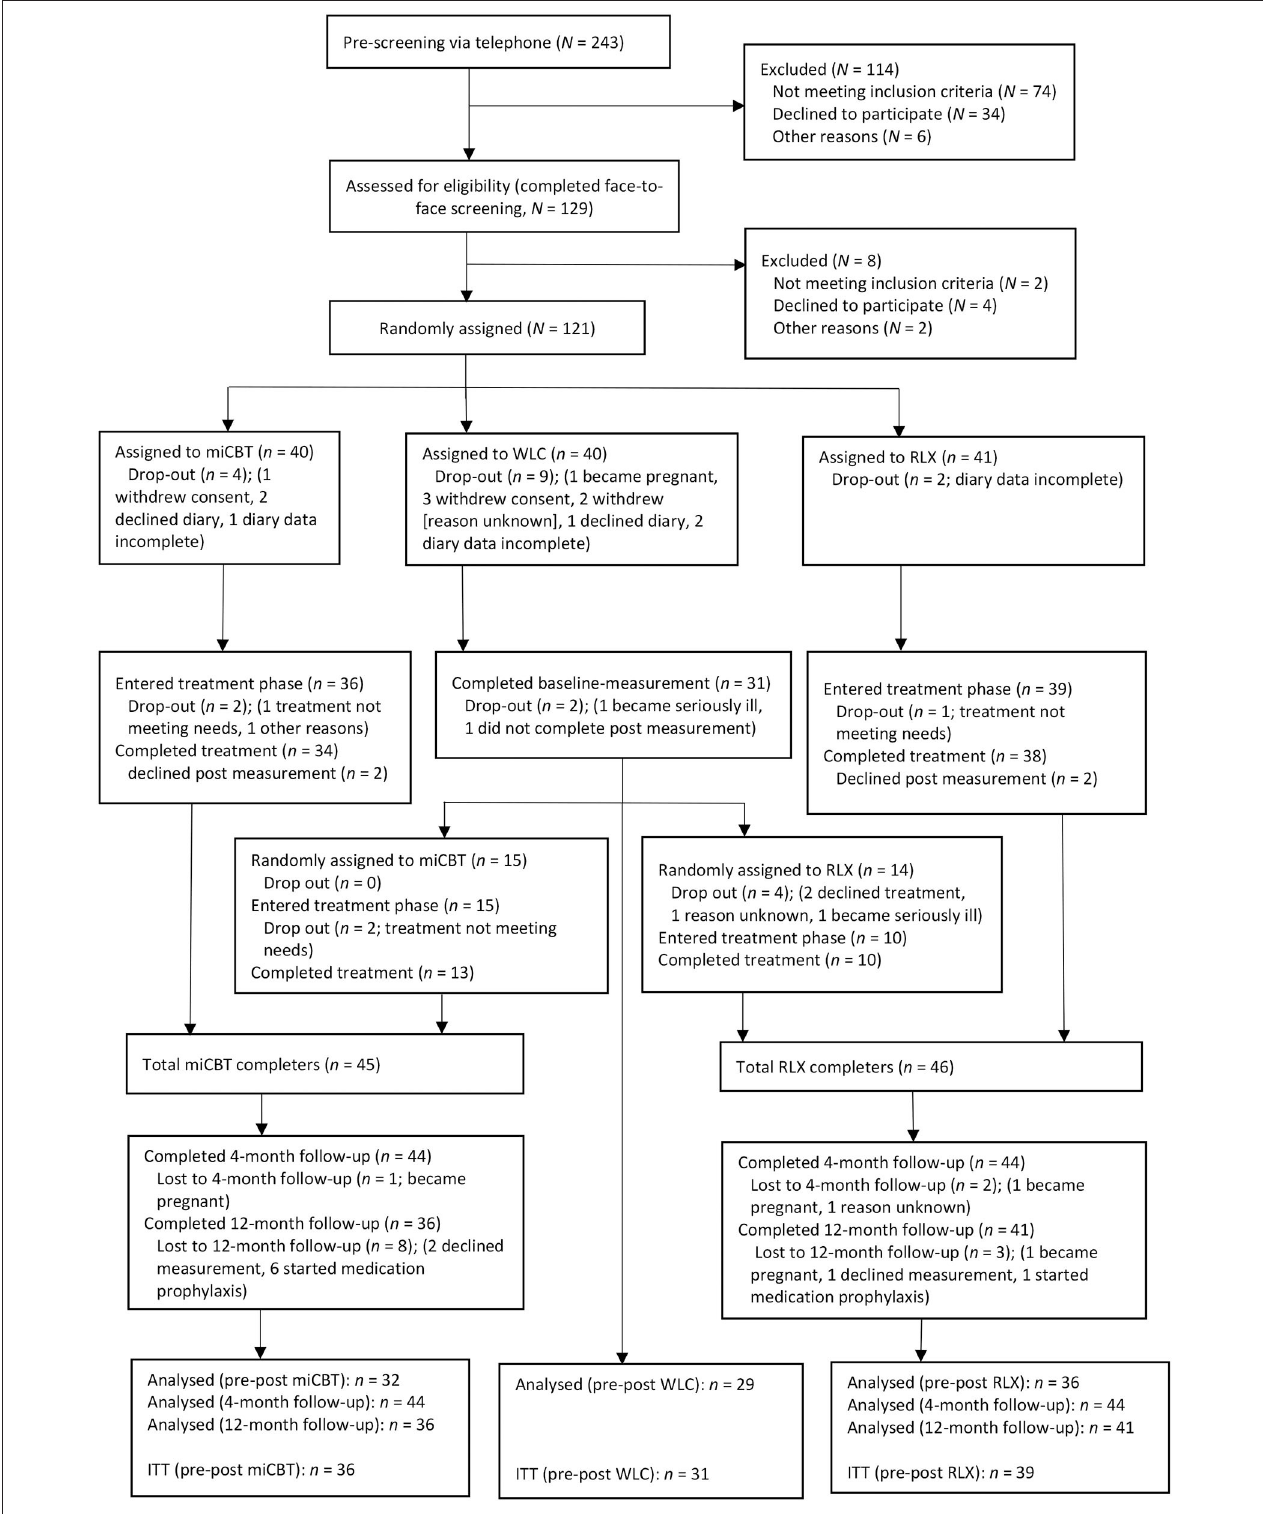
FIGURE 2 | Participant flow. miCBT, migraine-specific, integrative cognitive-behavioral therapy program; RLX, relaxation training; WLC, waiting-list control-group; ITT, intention-to-treat.